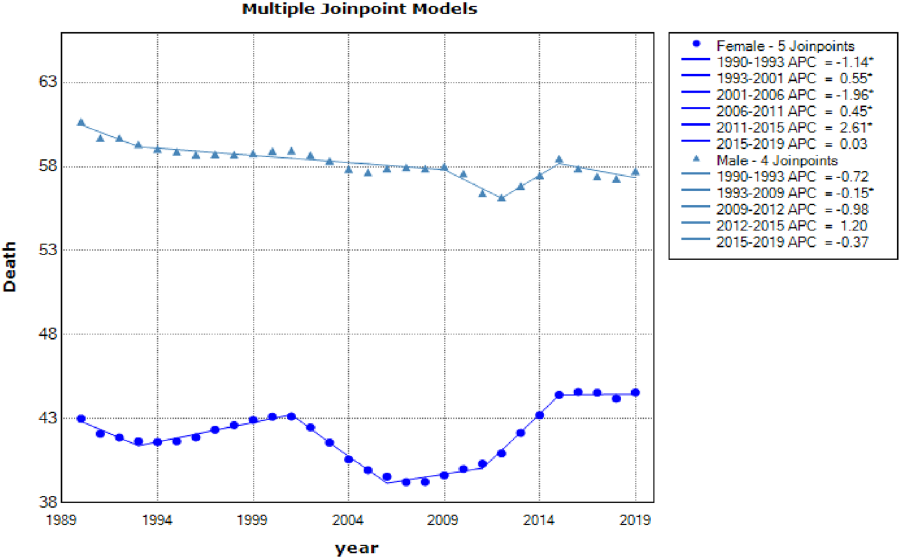
Figure 8. Joinpoint regression model for death due to air pollution exposure aged +50 by gender: 1990–2019.